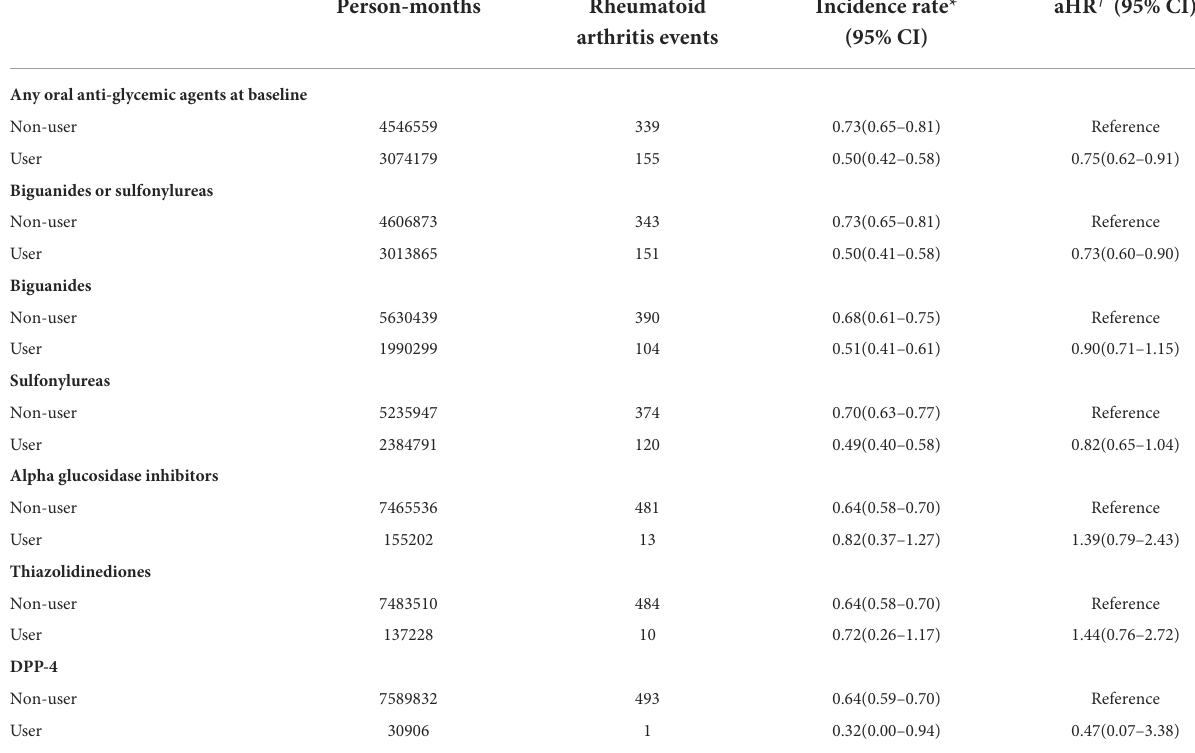
TABLE 2 Risk of rheumatoid arthritis among diabetes patients.